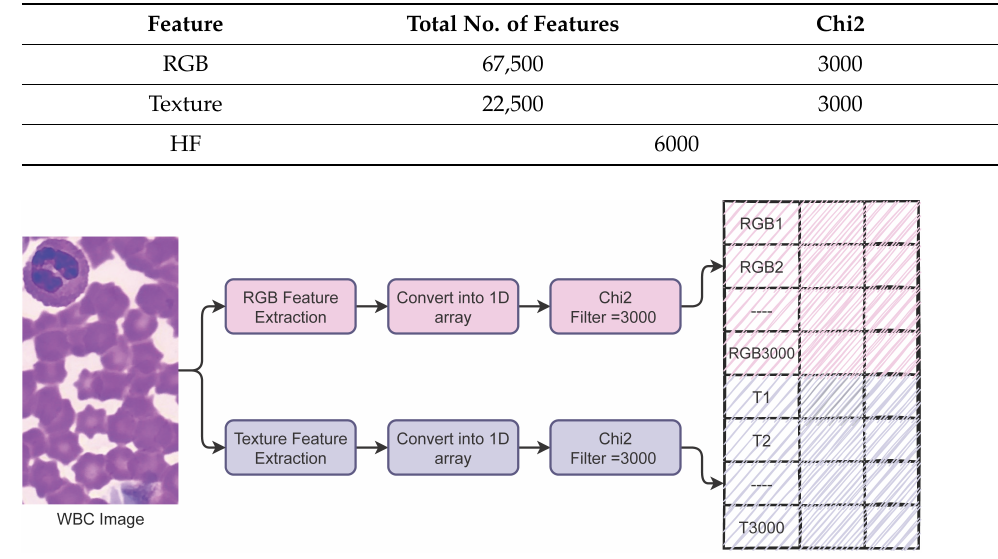
Figure 4. Process followed to make the hybrid feature set.